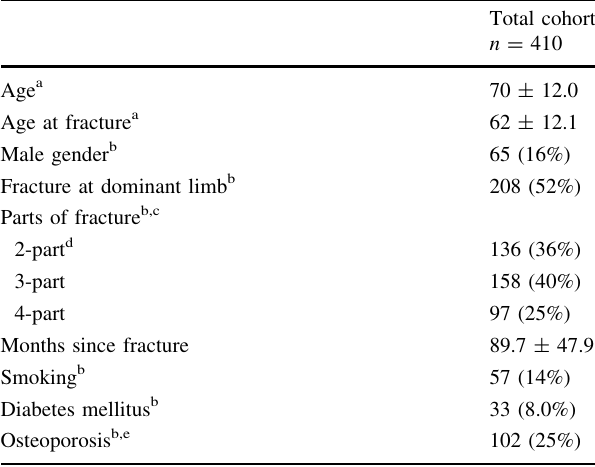
Table 1 Baseline characteristics of the cohort, surviving the follow- up ( n = 410 patients,) returning the questionnaire completely filled